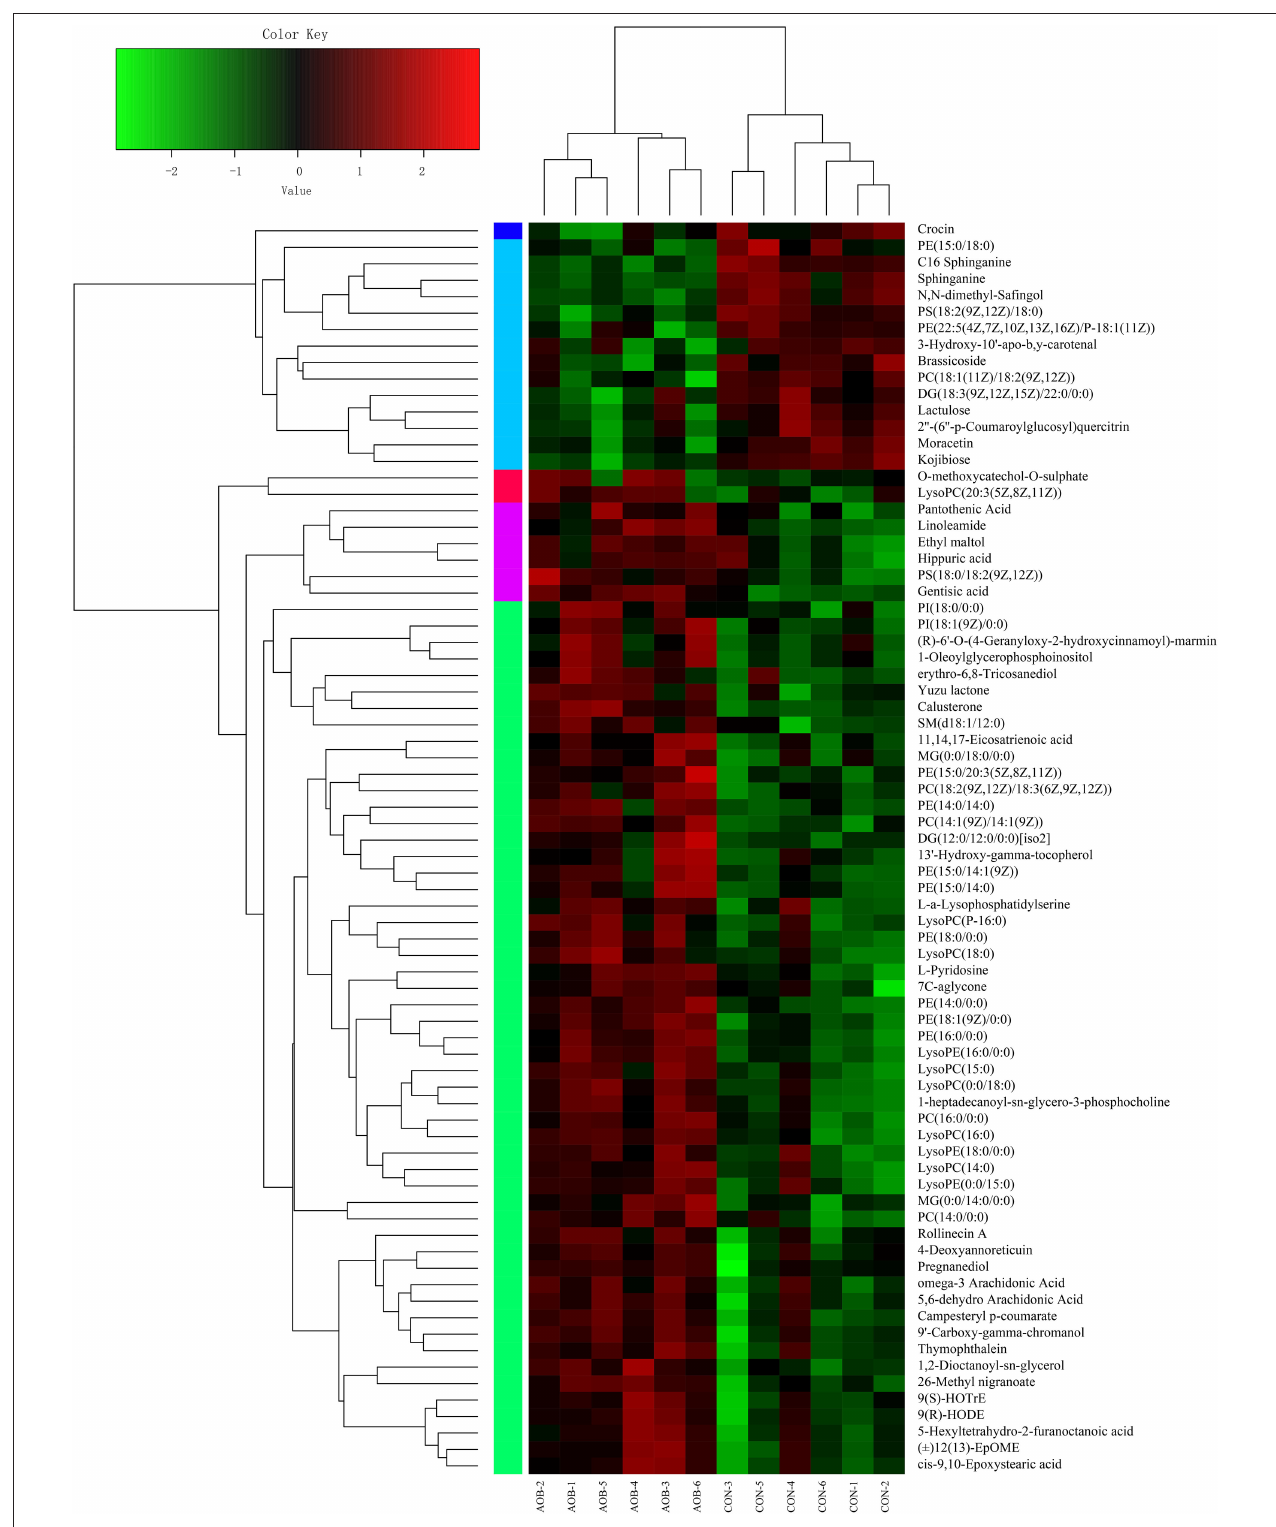
FIGURE 6 | Hierarchical clustering analysis (HCA) and heat map for different milk metabolites from the CON and AOB groups. The heatmap shows the significantly changed metabolites between the two groups. Columns in the heatmap represent one sample, and rows represent one metabolite. The color bar showing green to red indicates the relative content of the metabolites ( n =